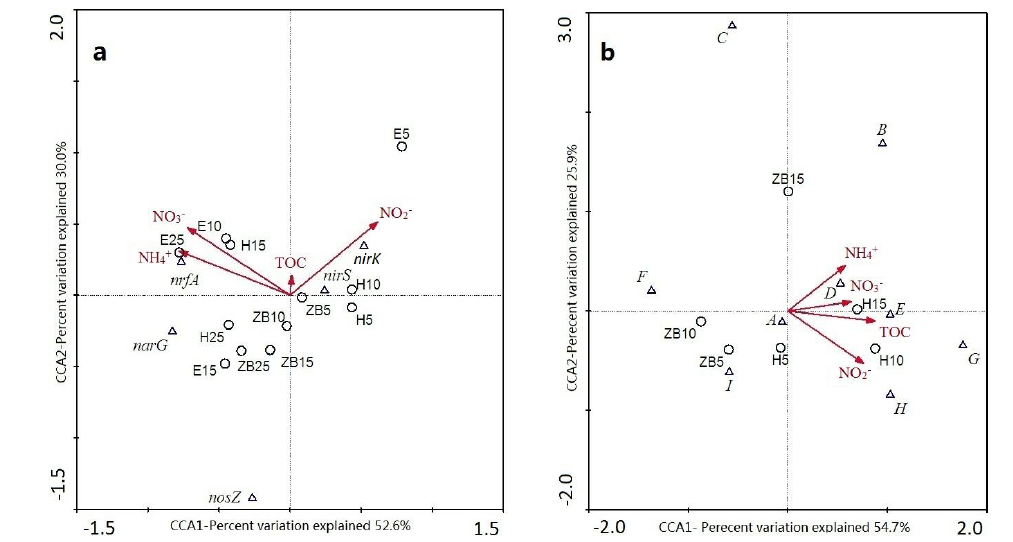
Fig. 2. Ordination plots of the canonical correspondence analysis (CCA) for the first two dimensions of CCA of the relationship between the distributions of (a) denitrifying genes and (b) nirS clusters vs. the nutrients in the Pearl River sediment. Correlations between environmental variables and CCA axes are represented by the length and angle of arrows (environmental factor